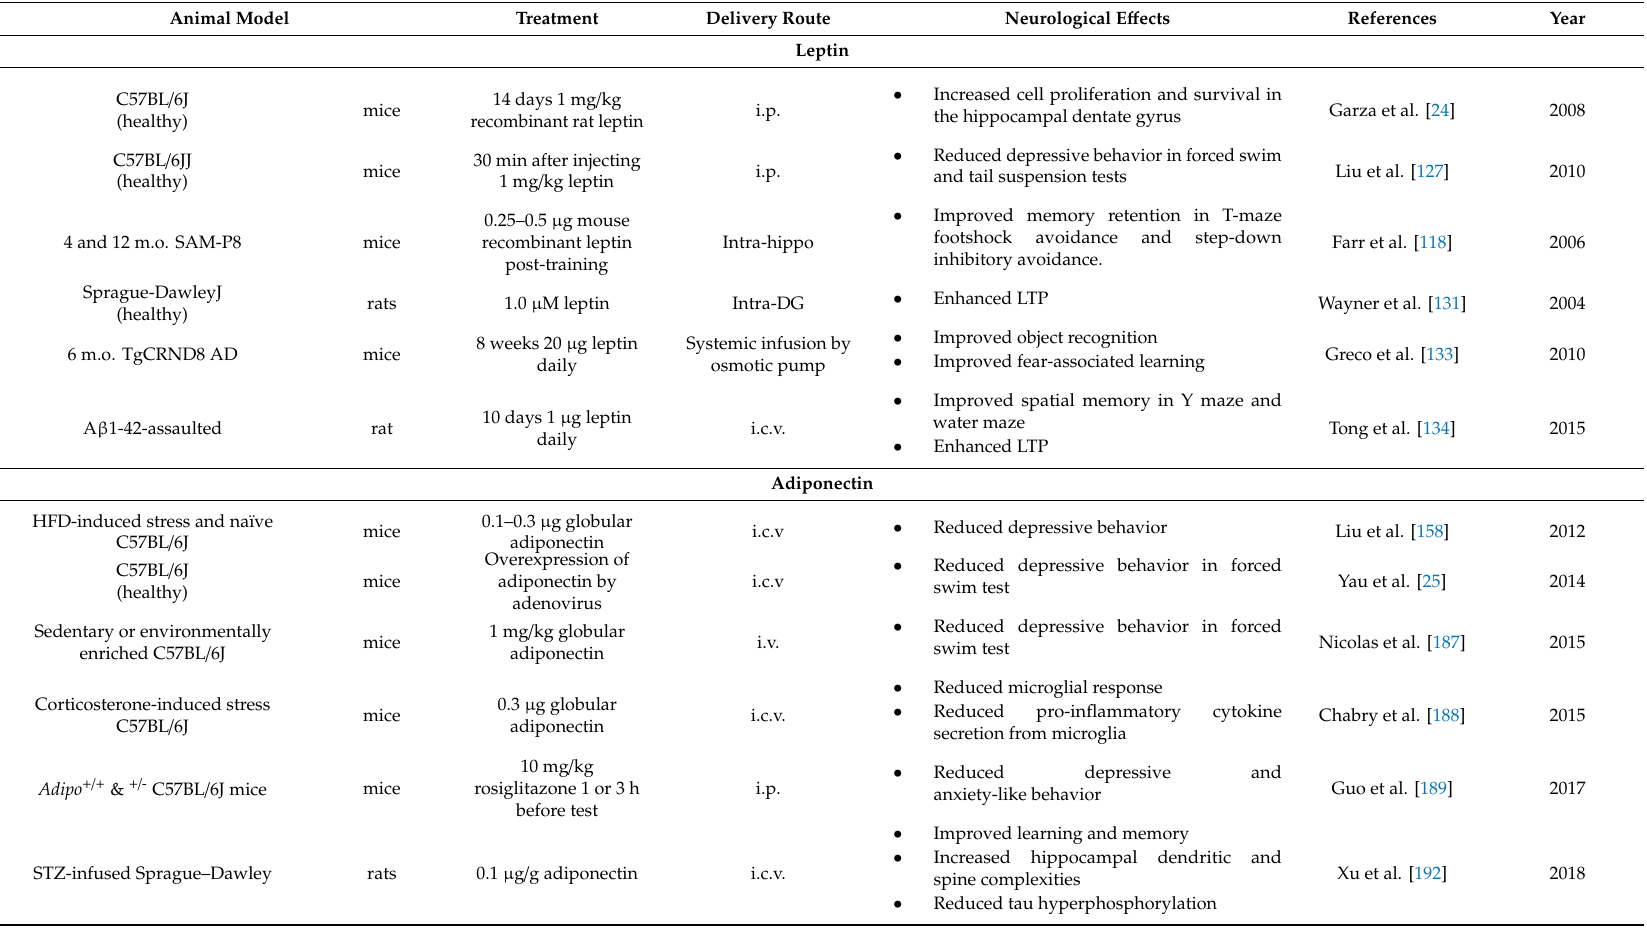
Table 1. E ff ects of adipokines on neuroplasticity, neuroprotection, and cognitive